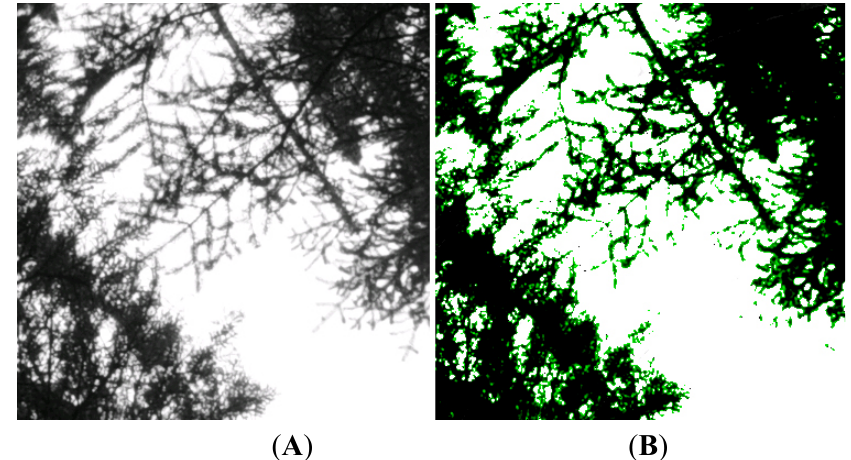
Figure 8. DHP thresholding example (1:1 resolution image ( A ); threshold image ( B ) black = vegetation, green = mixed, white =